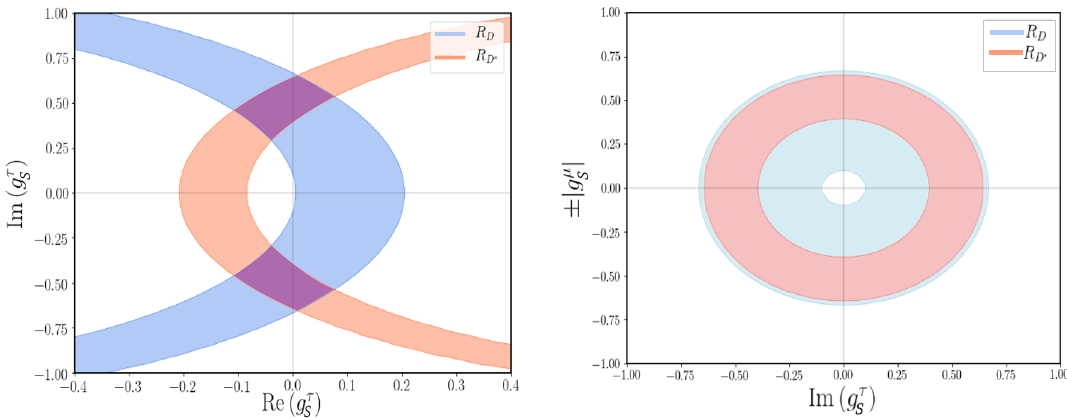
Figure 3 . Left: the 1 σ allowed ranges for R D and R D ? in the complex plane of g τ The purple shaded regions correspond to the allowed region that explains both R D and R D ? . Right: the 1 σ allowed ranges for R D and R D ? in the plane of ( g τ obtained by replacing g µ